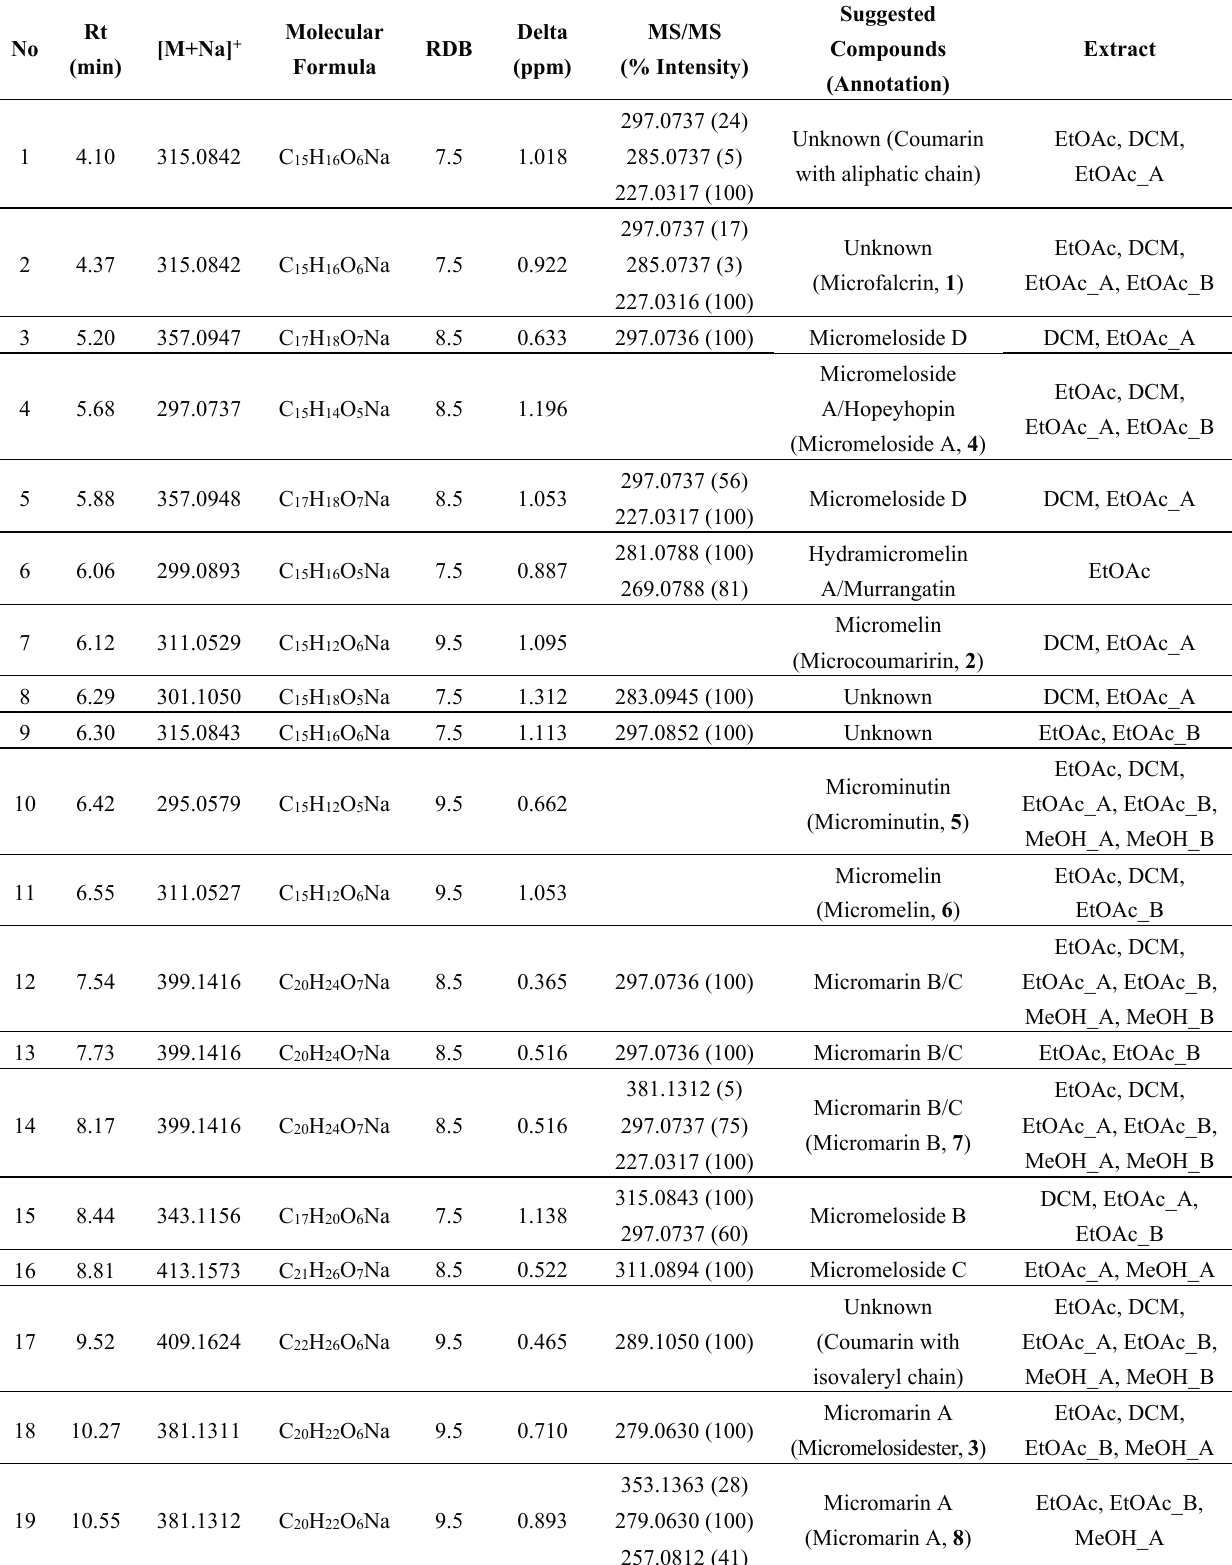
Table 1. 7-Oxygenated coumarin derivatives detected in M. falcatum extracts based on literature and UPLC-ESI(+)-HRMS/MS